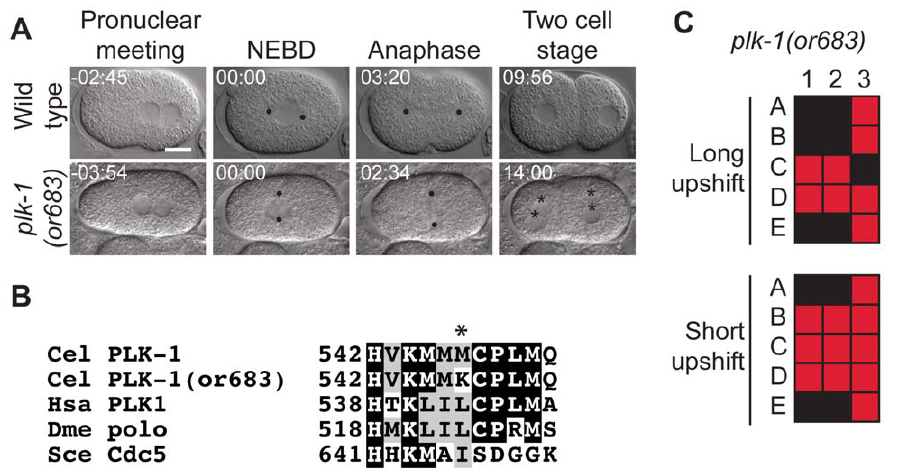
Figure 8. A plk-1 mutant. A. DIC time-lapse images of wild-type and plk-1(or683 ts ) embryos. In the plk-1 mutant the nuclear centrosomal complex (NCC) failed to rotate, a transverse P 0 spindle assembled, and the daughter blastomeres were binucleate. The plk-1(or683 ts ) embryo was obtained from a hermaphrodite shifted to the restrictive temperature for 6 hours prior to imaging. Black dots represent centrosomes/spindle poles and asterisks denote multiple nuclei per cell at the two cell stage. Times in min:sec are given relative to NEBD. Scale bar, 10 m m. B. Amino acid alteration in the mutant. Asterisk indicates changed residue. Homologous proteins are aligned below the C. elegans protein. C. Defect map for individual embryos observed during time-lapse recordings, embryos are listed on the left and phenotypes are listed on the top: 1; nuclear centrosomal complex rotation, 2; spindle alignment, 3; one nucleus per cell at two cell stage. In the long upshifts, hermaphrodites were transferred to the restrictive temperature for 5–8 hours. In the short upshifts, embryos were harvested from hermaphrodites grown at 15 u C and immediately mounted on agar pads for imaging, which took , 1 min.